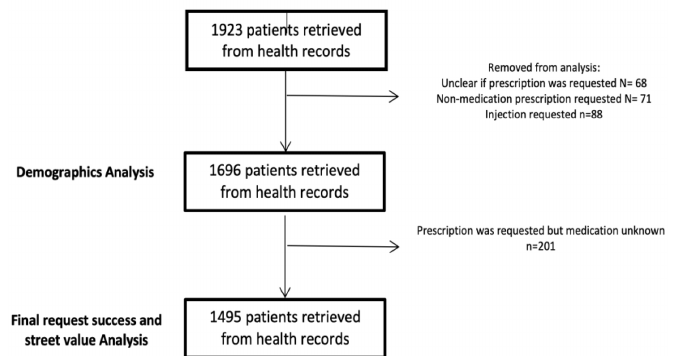
Figure 1. Patient health record selection process for the study.